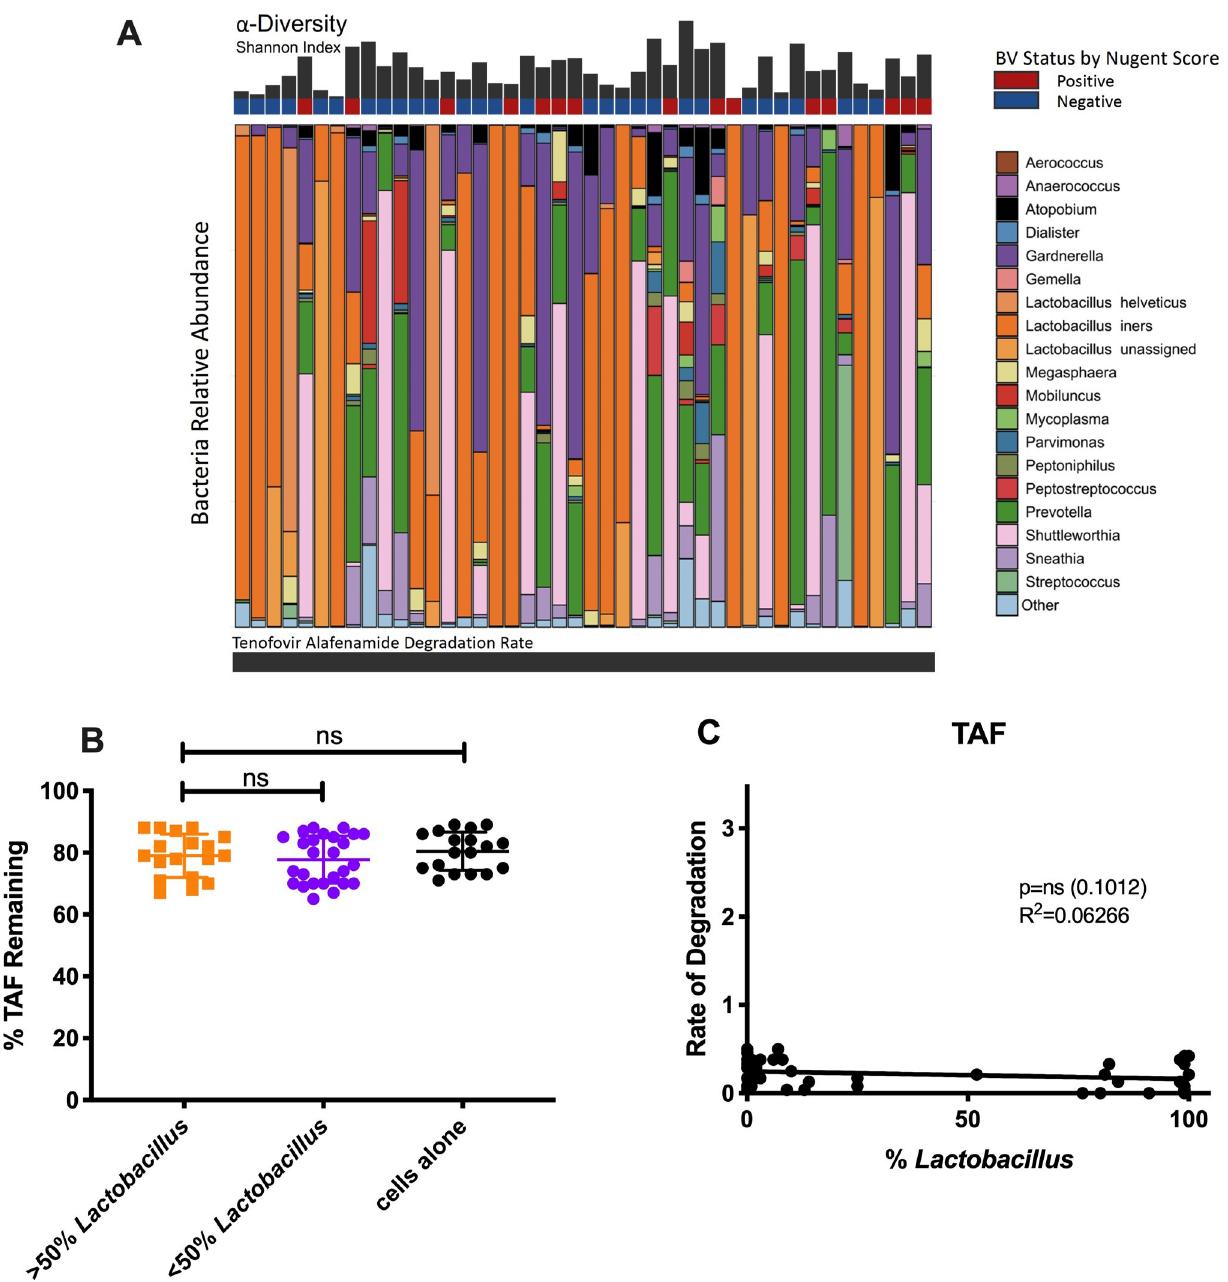
Fig 2. Effects of vaginal bacteria on TAF degradation. (A) Relative abundance of CVLs from 44 women with and without diagnosed BV ranked in order of increasing TAF degradation rates. The 19 most abundant phyla are shown. Shannon diversity plots showing alpha diversity in CVLs. Blue, BV negative by Nugent score at the time of collection; Red, BV positive by Nugent score at the time of collection. (B) % TAF remaining after 24 hours at 37C in Lactobacillus dominant vs. non- Lactobacillus dominant CVLs. Orange, greater than 50% dominance; Purple, less than 50% dominance; Black, cells + TFV control. (C) Rate of TAF degradation (% lost/hour) vs. % Lactobacillus in CVLs after 24-hour incubation. Rate of degradation calculated as % remaining/ 24